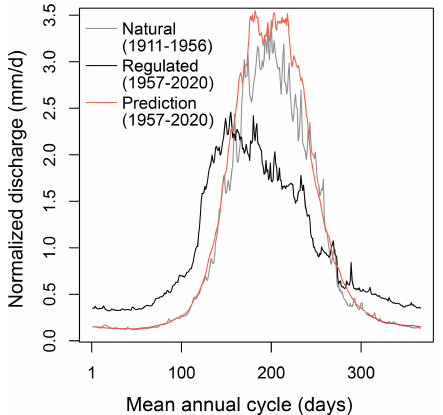
Figure 5. Comparison of the observed natural streamflow regime (i.e. the mean annual hydrograph) of the Dranse de Bagnes be- fore reservoir construction (grey; 1911–1956), observed regulated regime after reservoir construction (black; 1957–2020), and simu- lated natural regime for the period after reservoir construction (red;